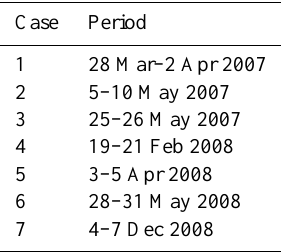
Table 8. List of aerosol transport cases and their periods for com-